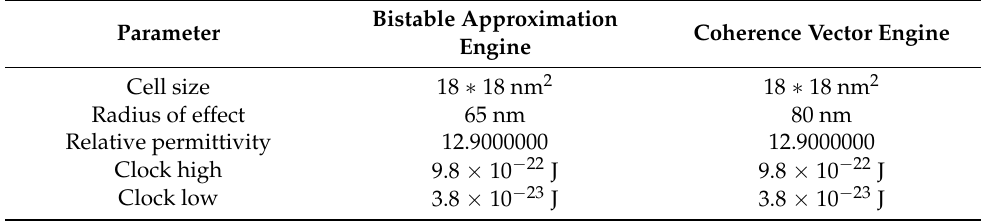
Table 2. QCADesigner parameters for “Coherence Vector” and “Bistable